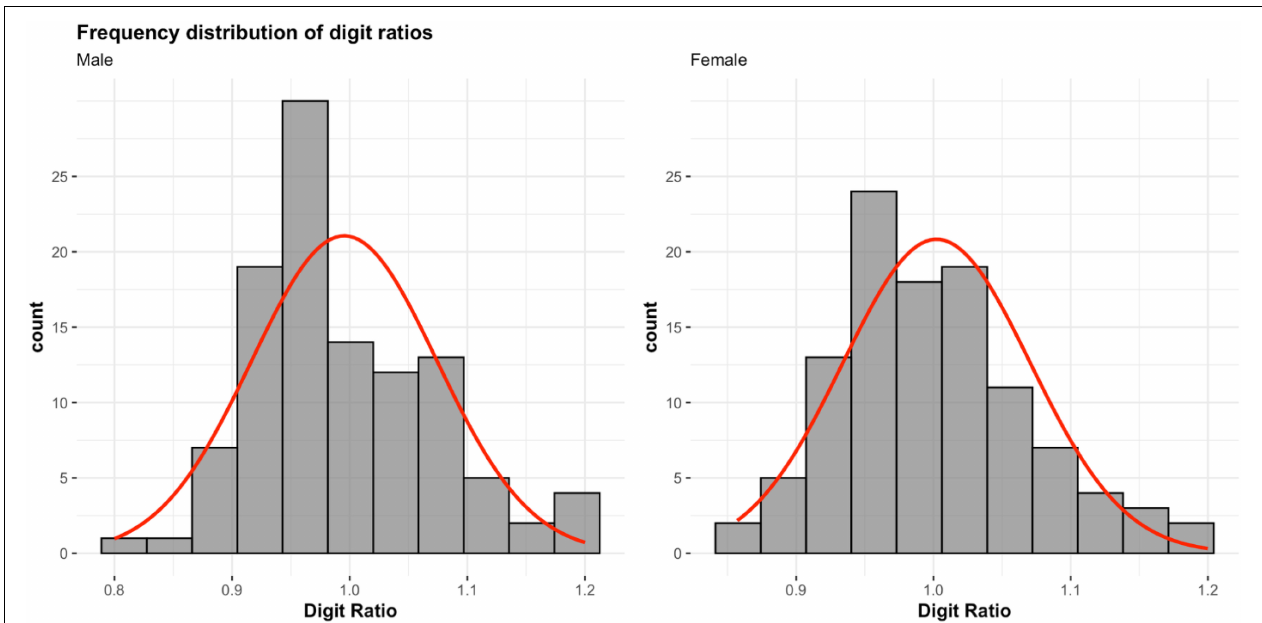
FIGURE 1 | Frequency distributions of digit ratios between male ( N = 108) and female participants ( N = 108). Red lines indicate overall distribution of self-reported digit-ratios.